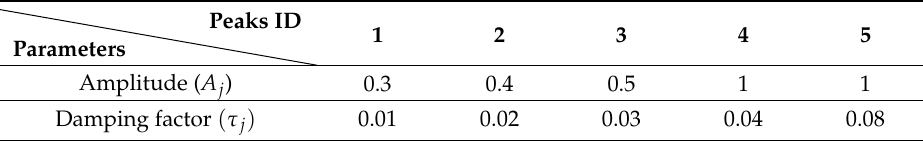
Table 3. Parameter settings of the synthetic 1D NMR